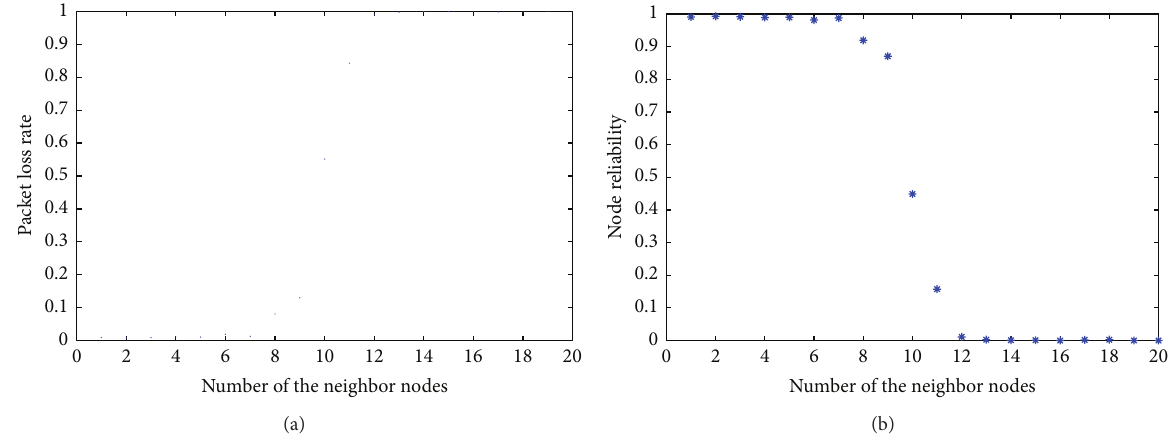
Figure 2: Packet loss rate (a) and node reliability (b) of the experiment.